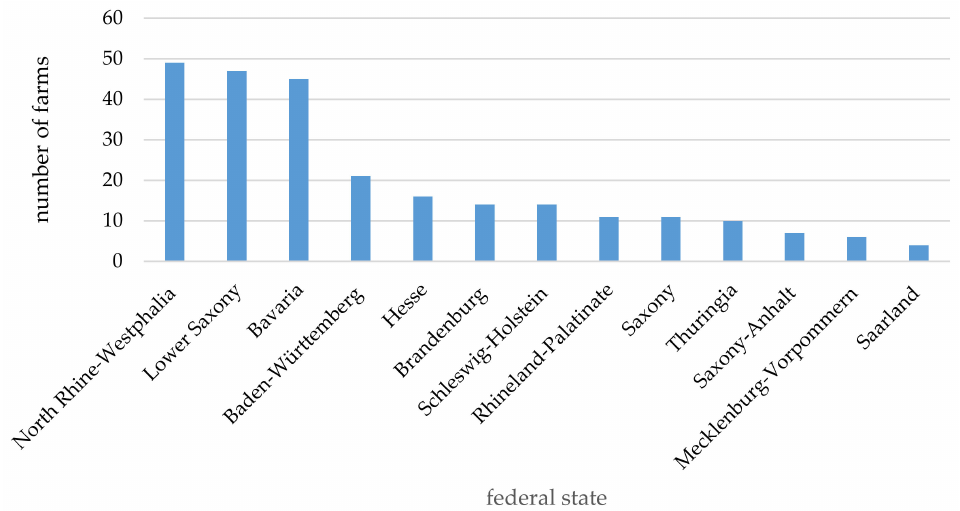
Figure 1. Number of farms by federal state (single choice; n = 255). A total of 55.1% ( n = 140/254) of the owners had started keeping South American camelids in the last six years (2014–2019) (Figure 2).